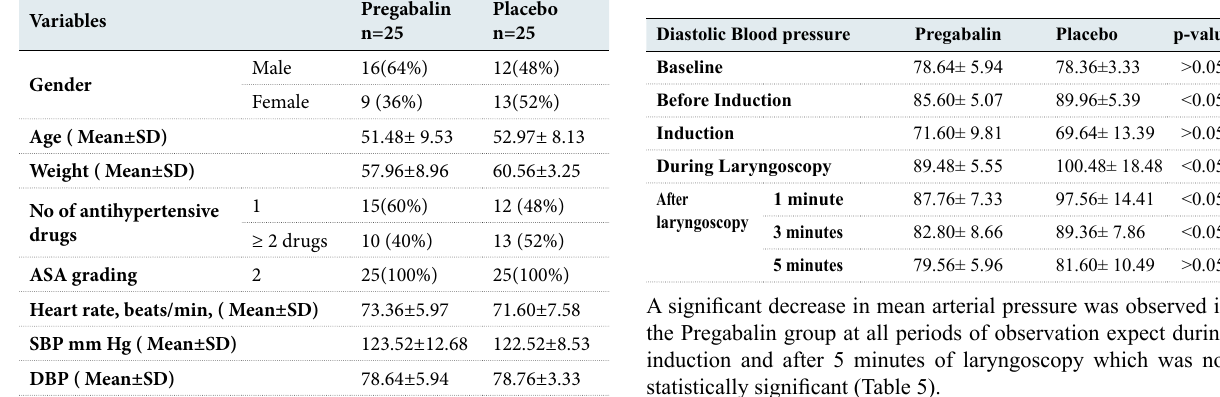
Table 4: Comparison of Diastolic Blood Pressure (Mean) in